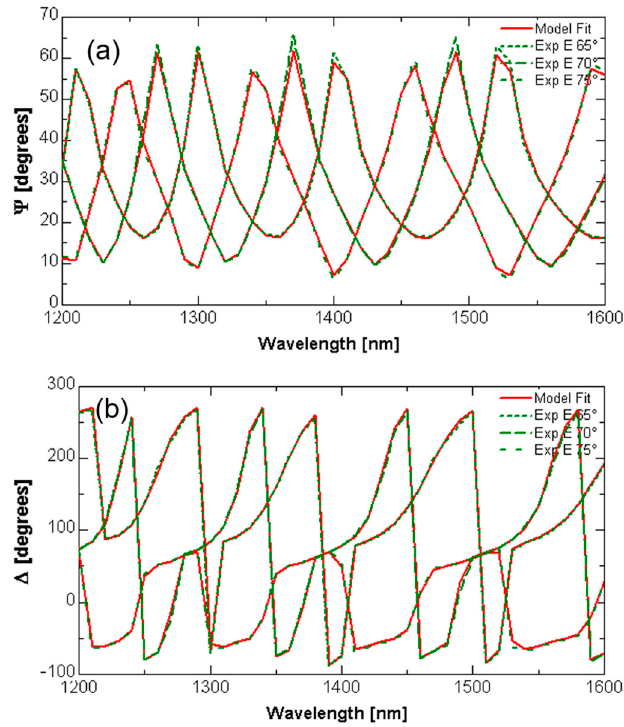
Figure 5. Ellipsometric ( a ) psi ( ψ ) and ( b ) del ( Δ ) data acquired at three angles of measurements (65°, 70°, and 75°) and their respective model curves (solid red lines) calculated with a four-layer film/substrate optical stack.